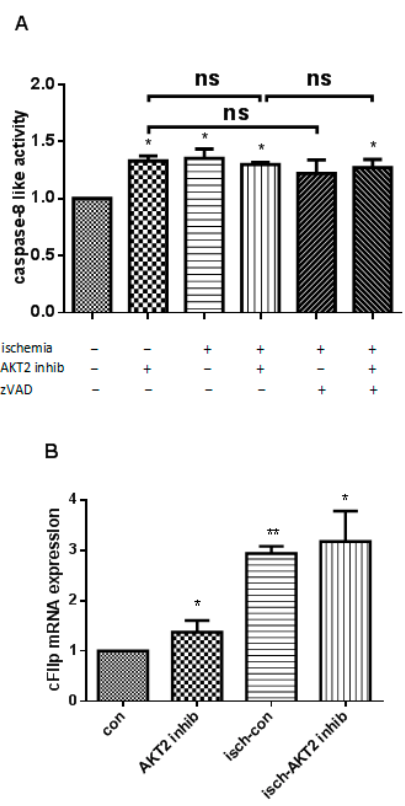
Figure 3. Inactivation of caspase-dependent apoptosis in ischemic cardiomyocytes treated with an AKT2 inhibitor. ( A ) Initiator caspase-8 activity in extracts of cardiomyocytes with con, an AKT2 inhibitor, and ischemic cardiomyocytes treated with or without AKT2 inhibitor and/or zVAD; ( B ) Quantitative real time PCR of cFlip transcript in cardiomyocytes with the same treatment as in A. zVAD: pan-caspase inhibitor z-VAD - fmk, 100 μ M. The bars represent the mean ± SEM of three independent experiments. * p < 0.05, ** p < 0.01 vs. control (one-way ANOVA followed by a Tukey test for post hoc analyses). ns: not significant.